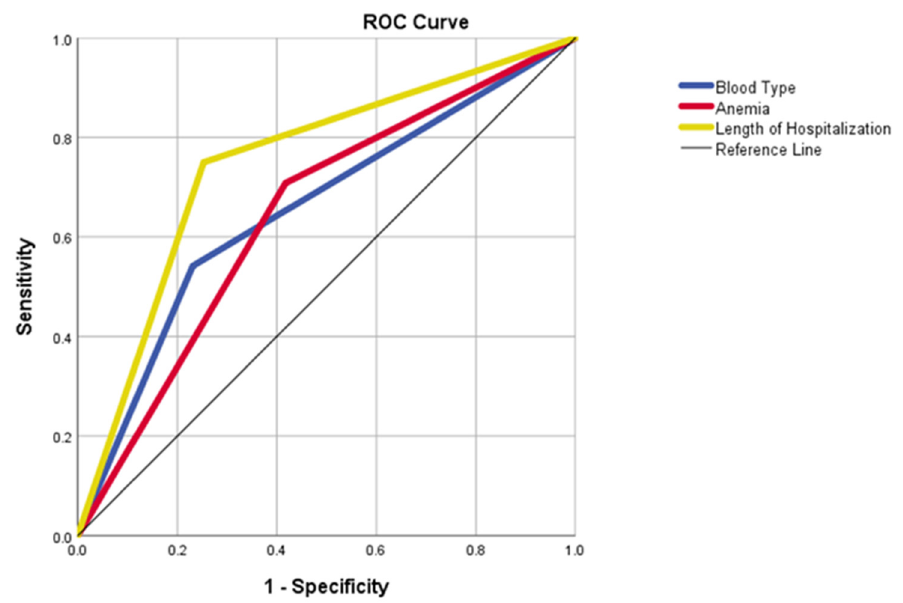
Figure 1. Evaluation of the predictive power of the analyzed variables (blood type 0, LH over 14 days and the presence of anemia) based on the ROC curve (Receiver Operating Characteristic). 14 days and the presence of anemia) based on the ROC curve (Receiver Operating